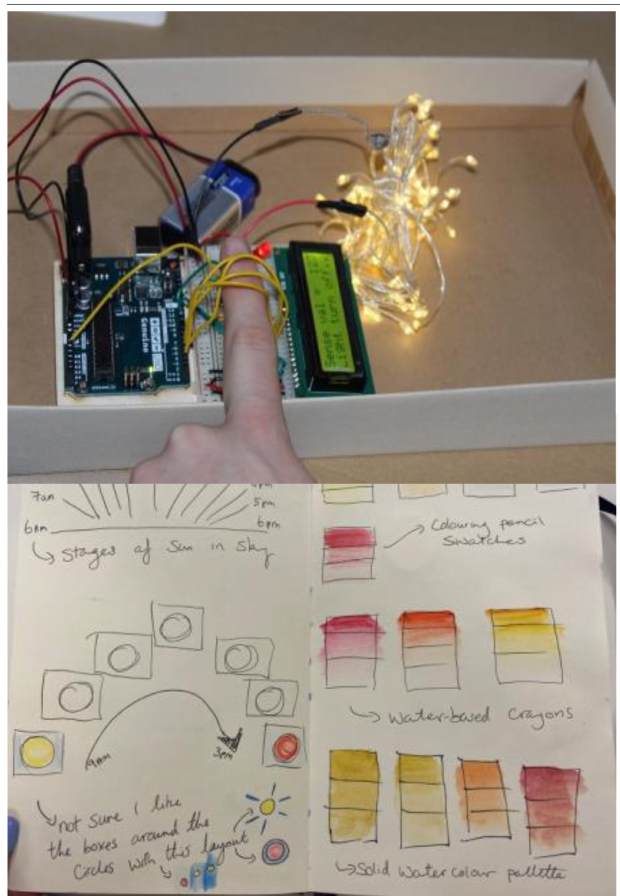
TABLE 2 | Pedagogical approaches used when integrating an IoT based environment monitoring system into STEAM